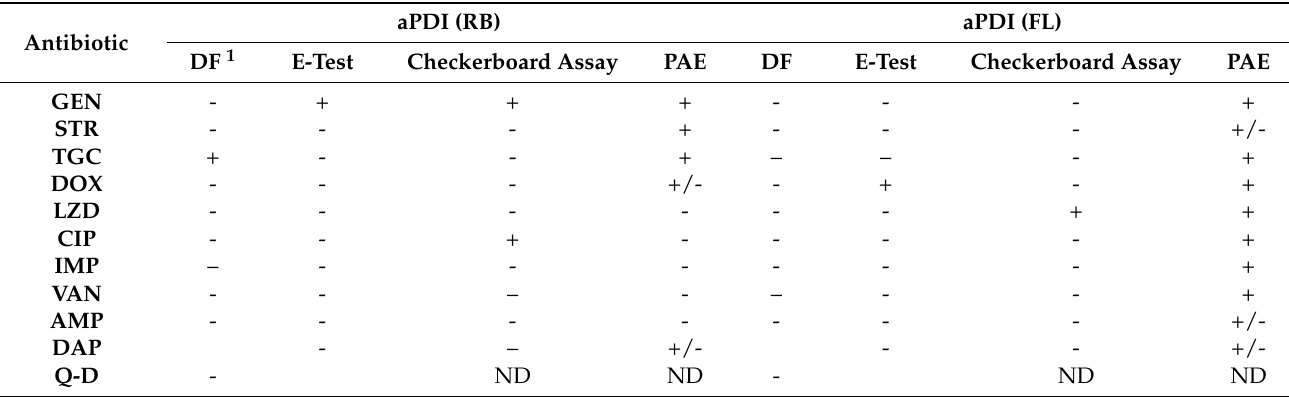
Table 4. Summarized results of synergy testing for E. faecium